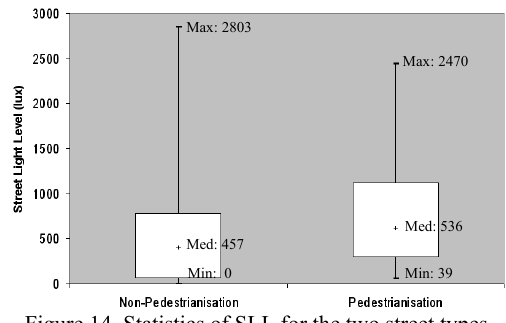
Figure 14. Statistics of SLL for the two street types From Figure 14, the 25th and 75th percentile together with the medium of the data collected in pedestrian areas are higher than those in non-pedestrian areas, indicating that the street light level in pedestrianized street is generally higher than in non- pedestrianized